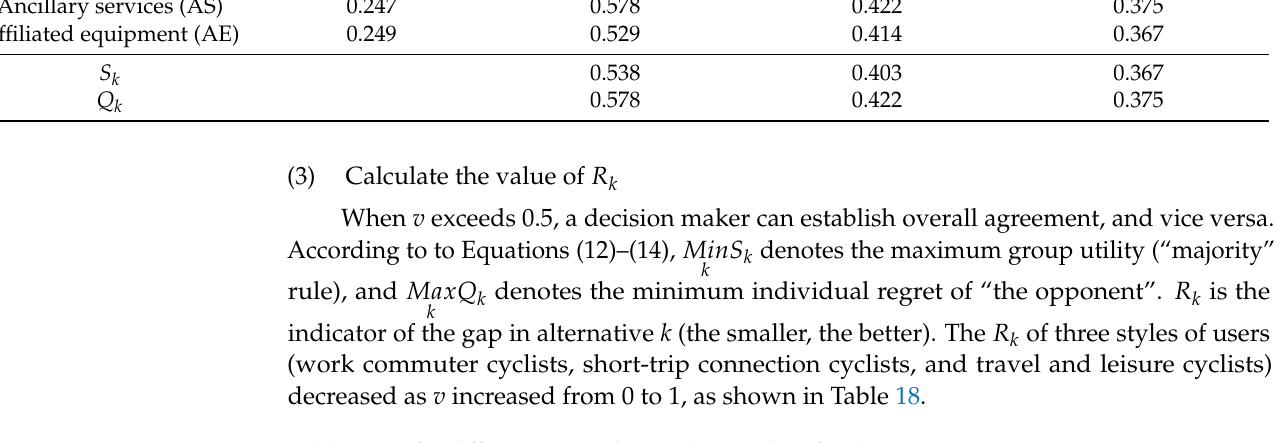
Table 18. R k for different v according to three styles of